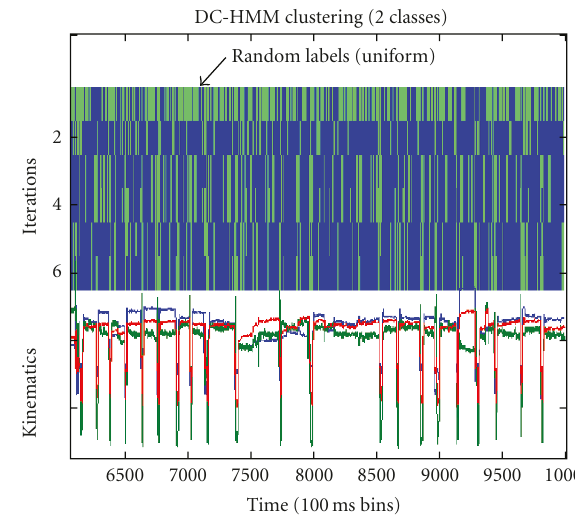
Figure 17: LM-HMM Clustering on monkey food grasping task (2